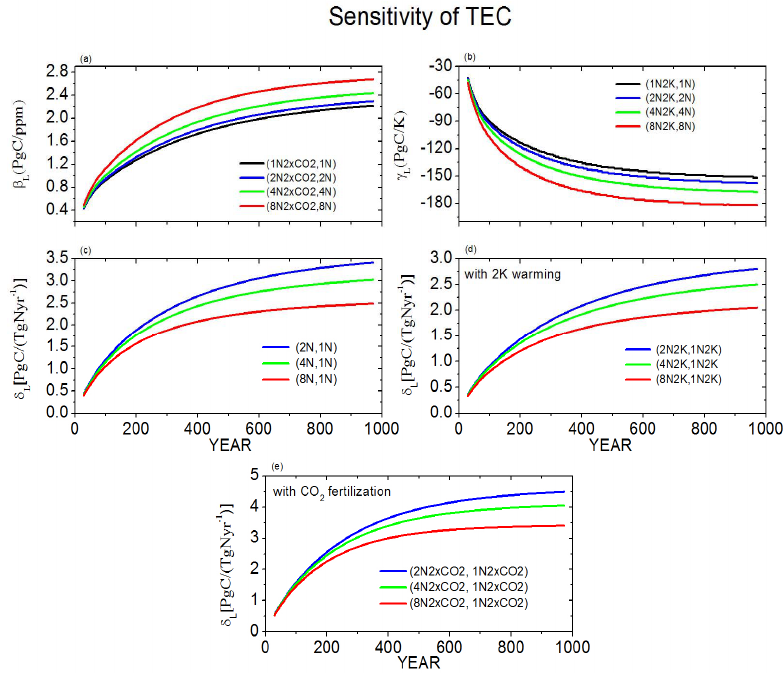
Fig. 7. Evolution of terrestrial ecosystem carbon (TEC) storage sensitivity to CO 2 , climate warming and increased N deposition in our 1000yr simulations. TEC sensitivity to (a) atmospheric CO 2 (β L ) at different levels of N deposition, (b) temperature ( γ L ) at different levels of N deposition, (c) N deposition ( δ L ) , (d) N deposition ( δ L ) in presence of 2K warming and (e) N deposition ( δ L ) in the presence of doubled CO 2 . A 57yr running average is applied to original annual mean TEC data. The pairs of experiments indicated in the legend are the experiments that are used to calculate the respective sensitivities (Eqs.